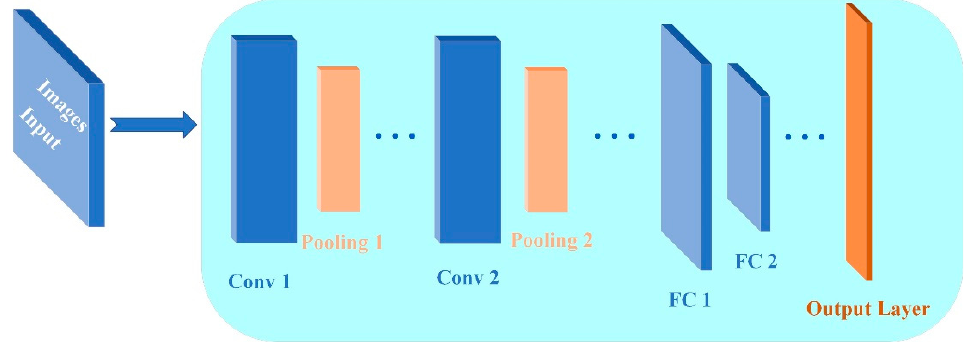
Figure 7. Basic structure diagram of a CNN.